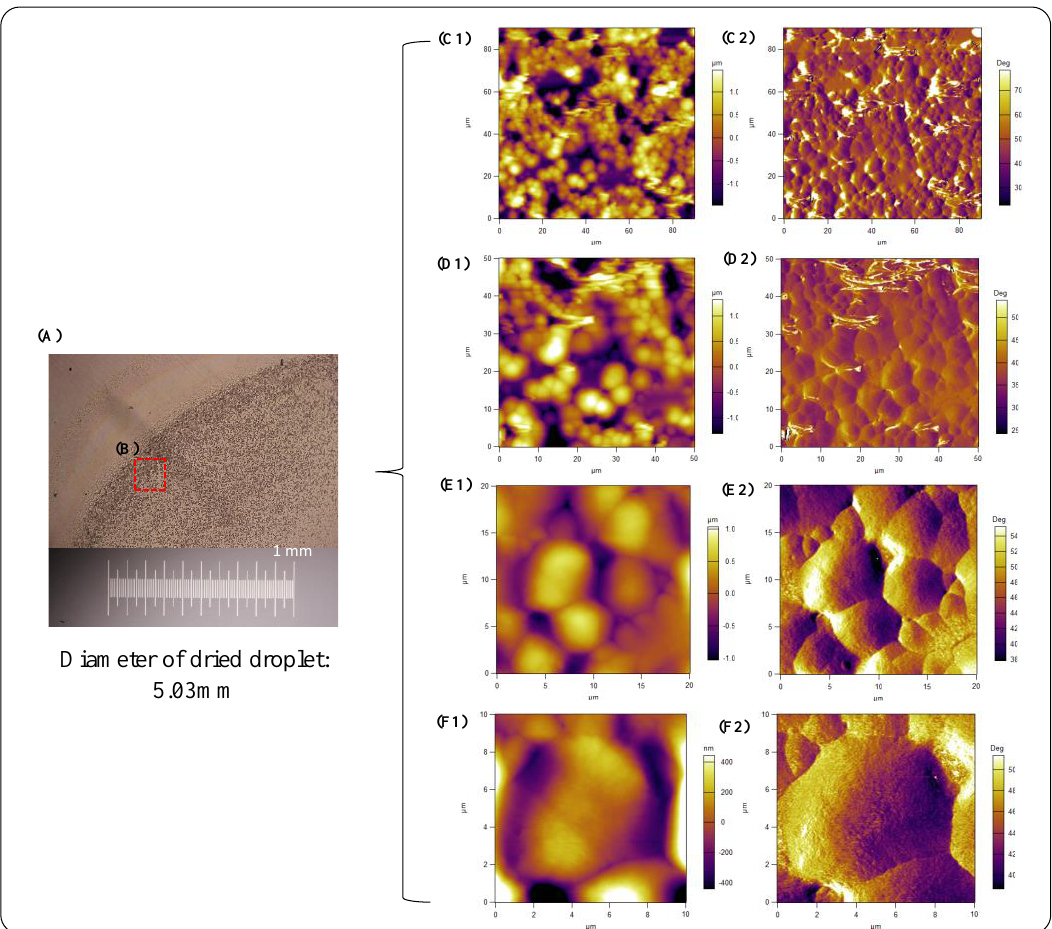
Figure 1. ( A ) Optical microscopy image of a partially dried PVDF/DMF solution droplet about 5.03 mm in diameter. ( B ) AFM images of edge region of dried PVDF/DMF solution droplet. ( C – F ) AFM height and phase images of dried PVDF/DMF droplet. ( 1 ) height image, ( 2 ) phase images, ( C ) 90 µ m × 90 µ m; ( D ) 50 µ m × 50 µ m; ( E ) 20 µ m × 20 µ m; ( F ) 10 µ m × 10 µ